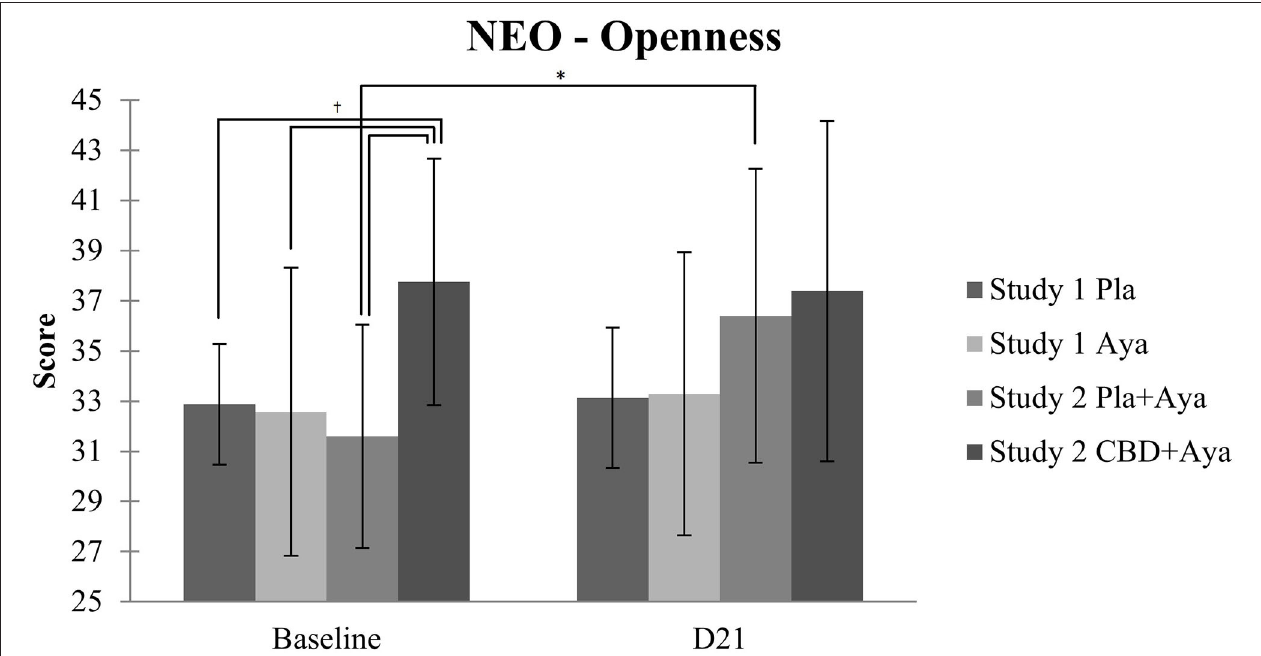
FIGURE 1 | Openness to experience scores (mean; SD) on the four groups between baseline and day 21 (D21): placebo and ayahuasca (study 1, n = 15), and CBD plus ayahuasca and placebo plus ayahuasca (study 2, n = 15). Significant differences were observed between groups at baseline ( † p < 0.05, corrected) and in the placebo plus ayahuasca group in study 2 from baseline to D21 (* p < 0.05,